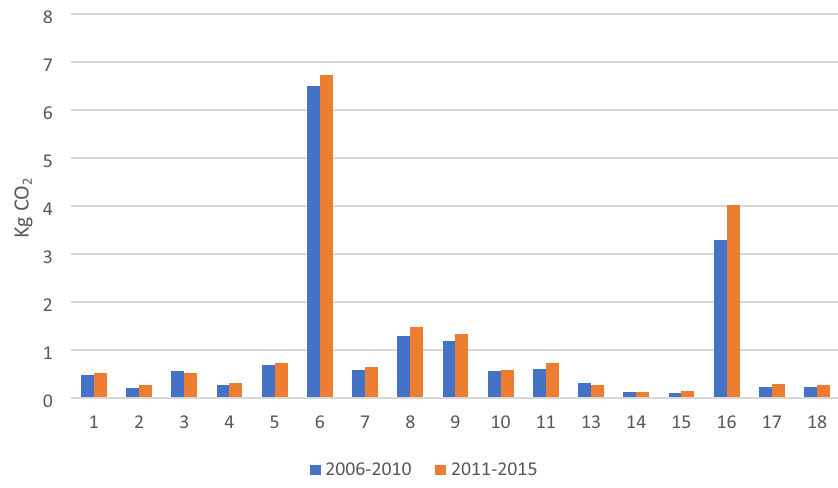
Fig. 3 Carbon emissions intensity of Vietnam’s exports by